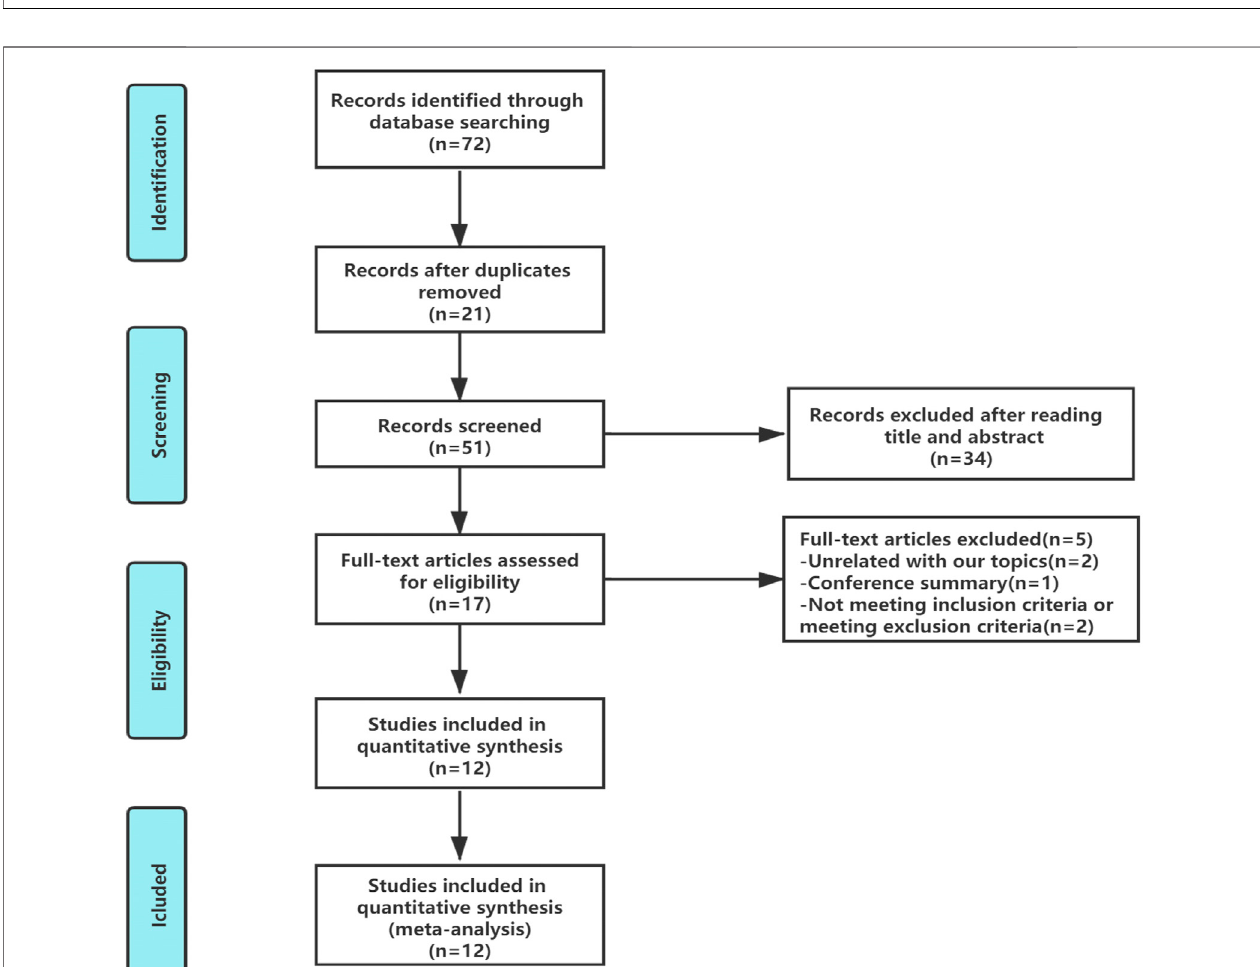
FIGURE 2 | Flow diagram showing study selection for the meta-analysis.